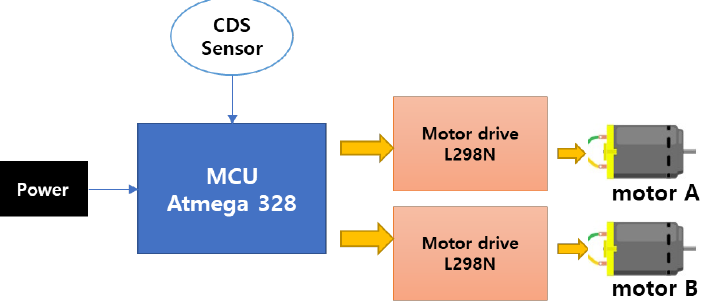
Figure 4. Hardware configuration block diagram.